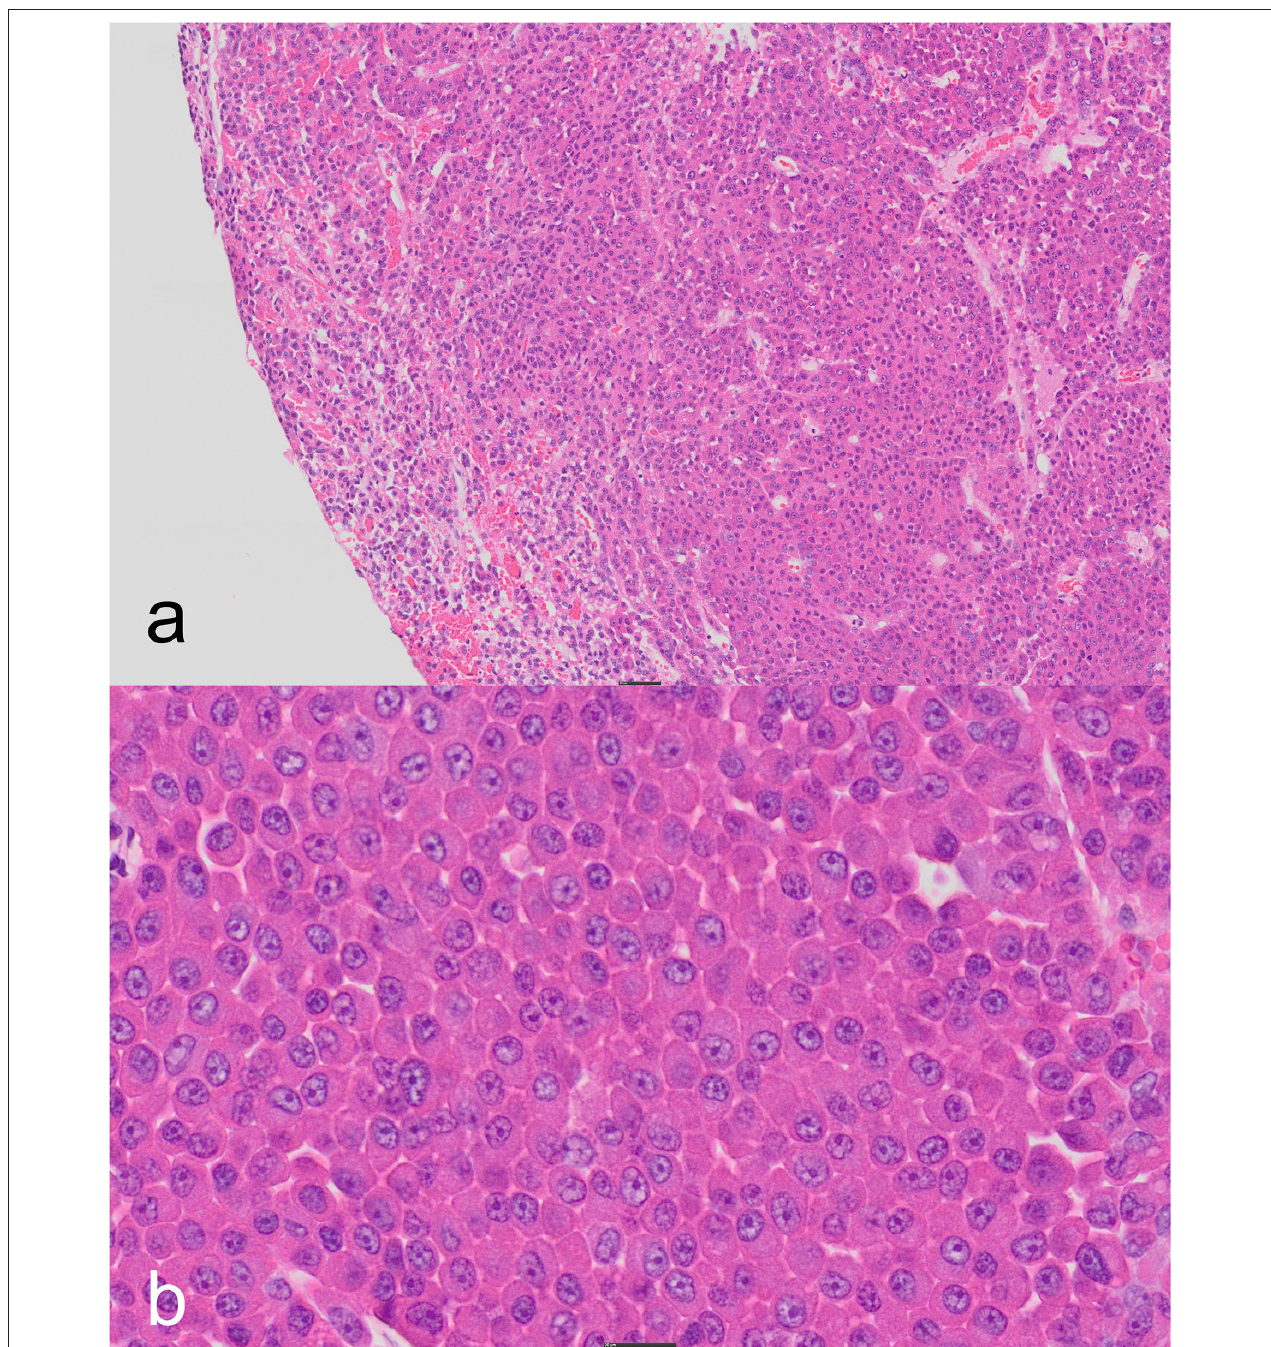
FIGURE 3 | Pituitary adenoma, cat. (a) The center of the tissue contains a non-encapsulated mass consisting of nests and cords of a monomorphic population of cells compressing the peripheral parenchyma with scant, acute hemorrhage (4 × objective lens). (b) Densely-packed sheets of well-differentiated, brightly eosinophilic, granular cells with large central nuclei and prominent, single nucleoli (20 × objective lens).